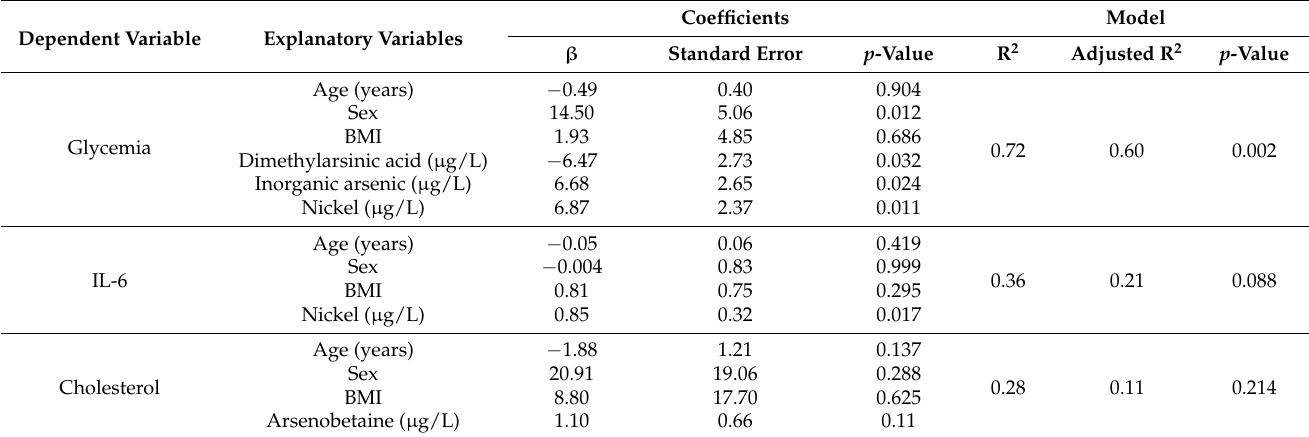
Table 3. Associations among chronic exposure to metals and glycemia, IL6, and cholesterol levels, in Chilean people, adjusted by age, body mass index, and sex (linear regression